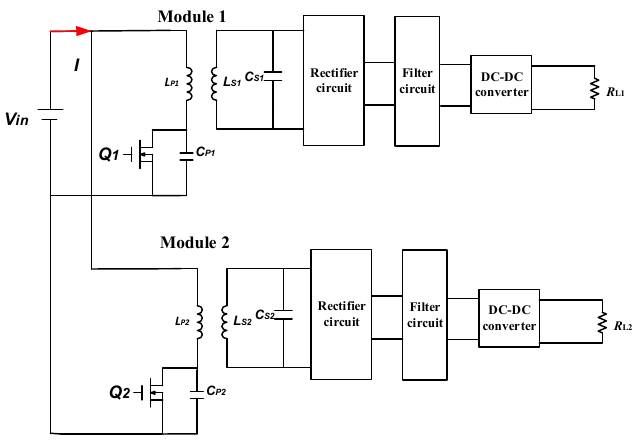
Figure 14. Two-way phase-shift topology .